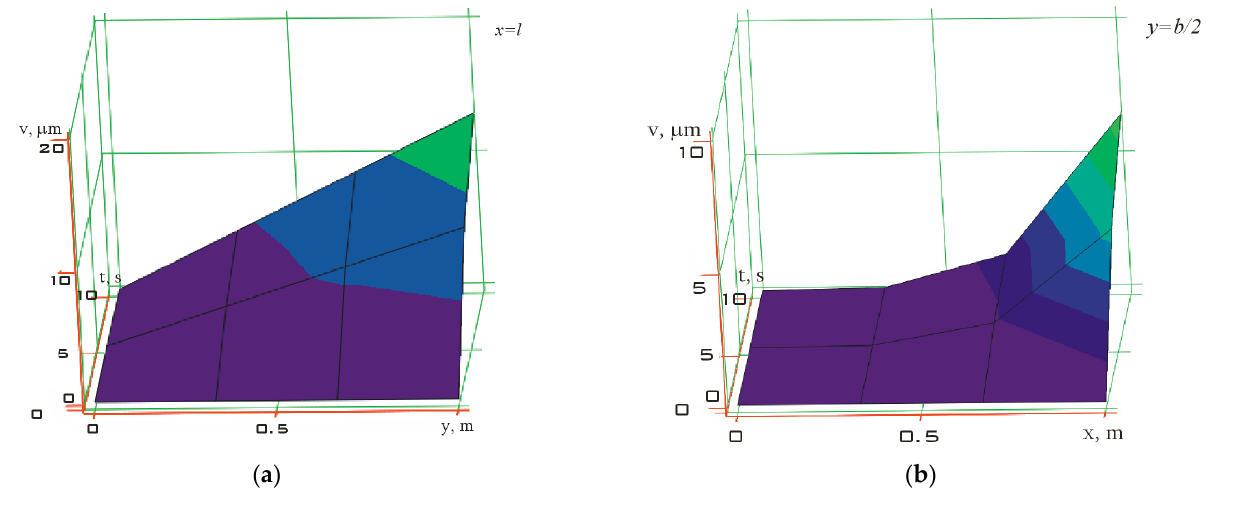
Figure 3. The function v ( x , y , t ) : ( a ) v ( x = l , y , t ) ; ( b ) v ( x , y = b , t ) . As can be seen from Figures 3 and 4, w >> v for all points of the plate. Therefore, the approximate solutions (11) and (12) could be used for practical estimation of the deformed state of the plate under temperature shock, despite the limitation